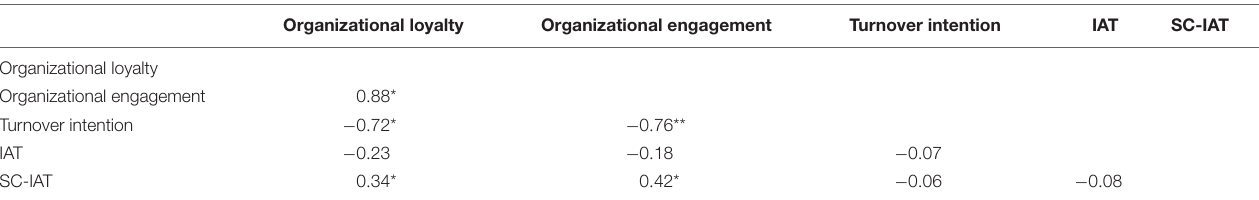
TABLE 5-3 | Correlation of